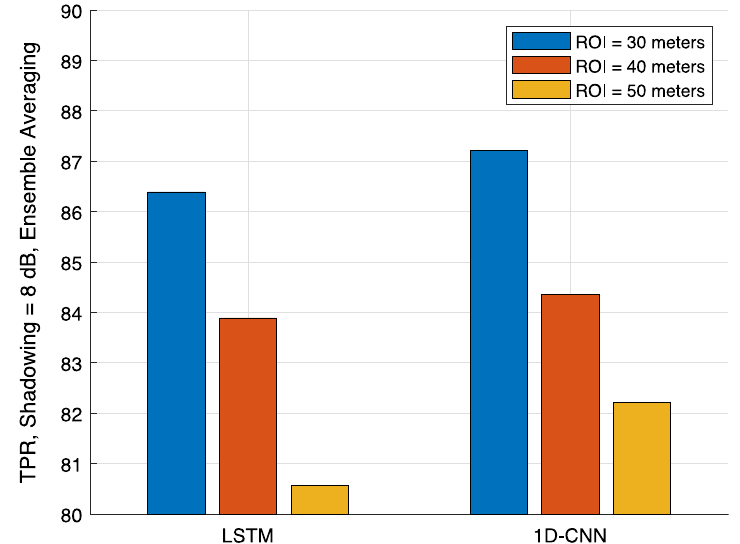
Fig. 12 Accuracies of proposed LSTM, proposed 1D CNN, and existing FFNN under ensemble averaging